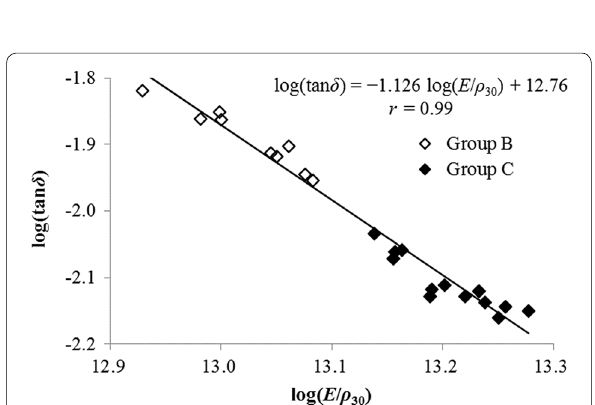
Fig. 4 Correlation between log ( E / ρ 30 ) and log (tan δ ) for the Group B and C specimens, and the best-fit regression line. This regression line satisfies all of the sugi samples at 30% moisture content